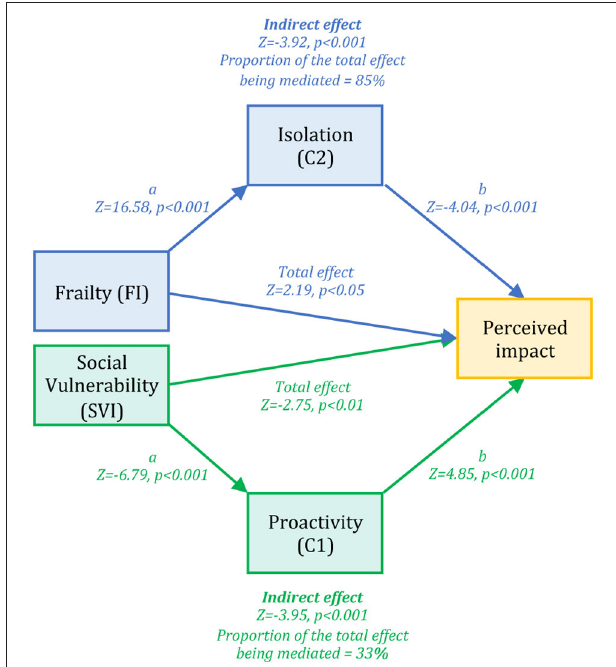
FIGURE 2 | Frailty and Social Vulnerability paths. The figure displays results emerged from the path analysis, including two different paths assessed separately, both converging on a common outcome, i.e., the individual perception of the impact of Covid-19 outbreak on health (yellow box). In the Frailty path (blue color) we observed a significant mediation effect of the independent component Isolation (C2) on the relationship between the frailty index (FI) and the perceived impact of Covid-19 outbreak on health. In the Social Vulnerability path we found a significant mediation effect of the independent component Proactivity (C1) on the relationship between the social vulnerability index (SVI) and the perceived impact of Covid-19 outbreak on